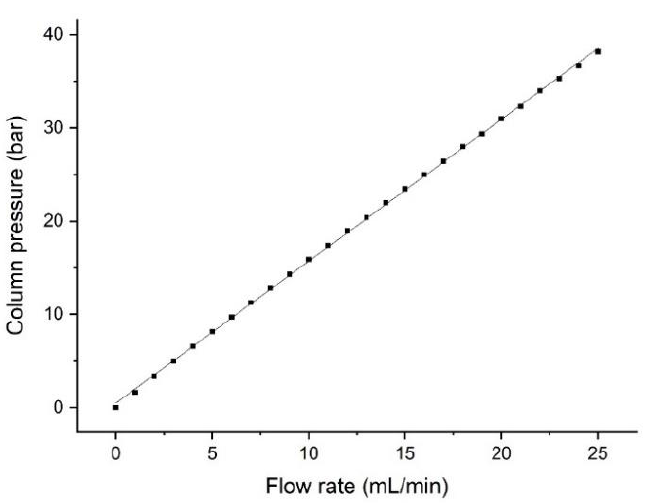
Figure 5 . The system pressure of a VitraPOR 5 column with an increasing flow rate.